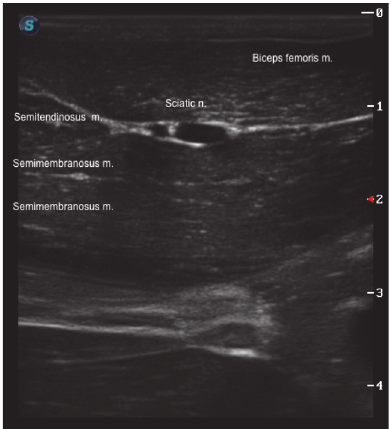
Figure 1: Sciatic nerve: ultrasonographic short axis view image of the sciatic nerve of a wallaby ( Macropus rufogriseus ). The sciatic nerve can be identified as a hypoechoic double-ellipsoid structure located deep to the fascia of the biceps femoris muscle and cranial and superficial to the two bellies of the semimembranosus muscle, respectively. S is